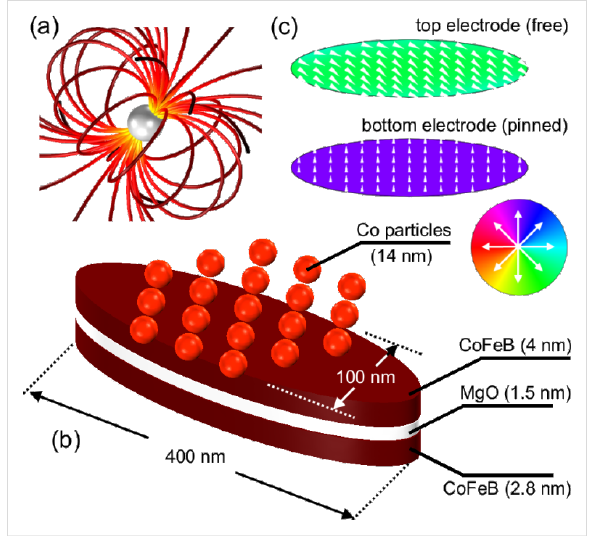
Figure 12: Schematic representation of the tunnel magnetoresistance (TMR) sensor setup for the detection of multiple Co nanoparticles of 14 nm diameter: (a) Stray field of a homogeneously magnetized particle, (b) TMR-sensor with particles on top, (c) magnetic equilibrium state of the ferromagnetic